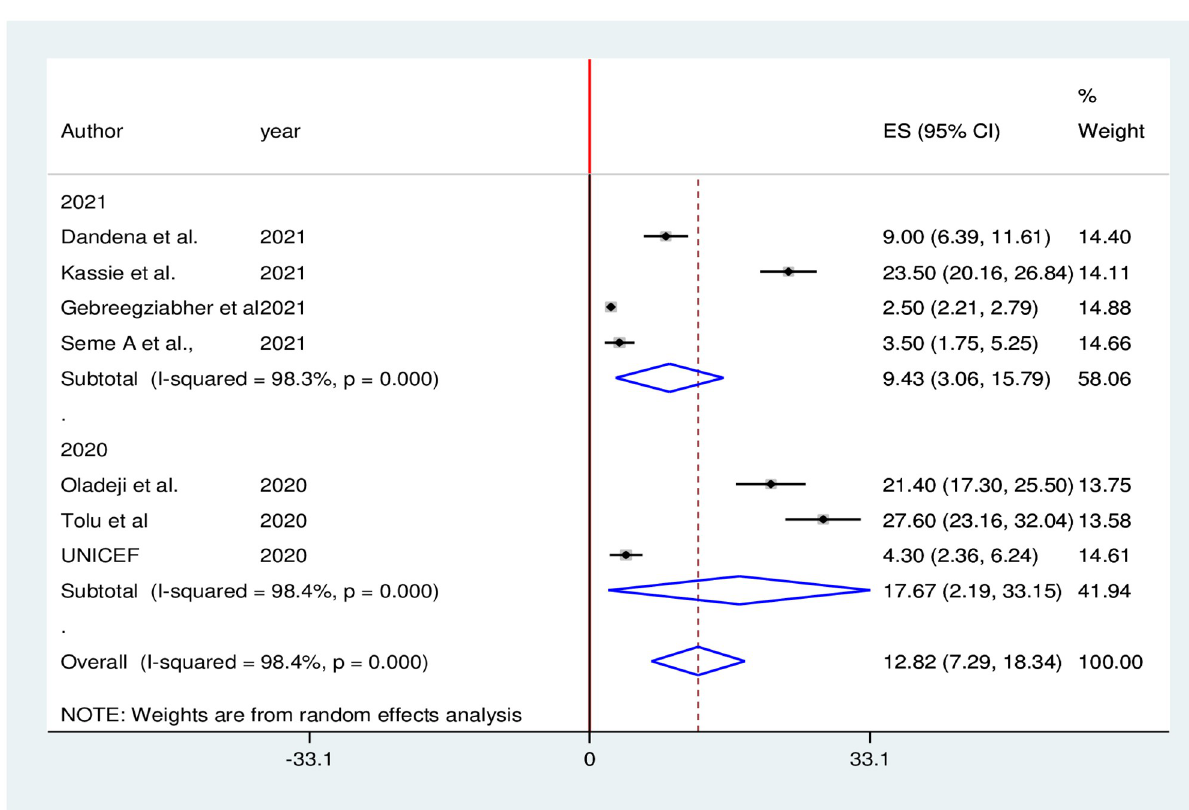
Fig 9. Subgroup analysis of institutional delivery services reduction during COVID-19 pandemic in Ethiopia, 2021.